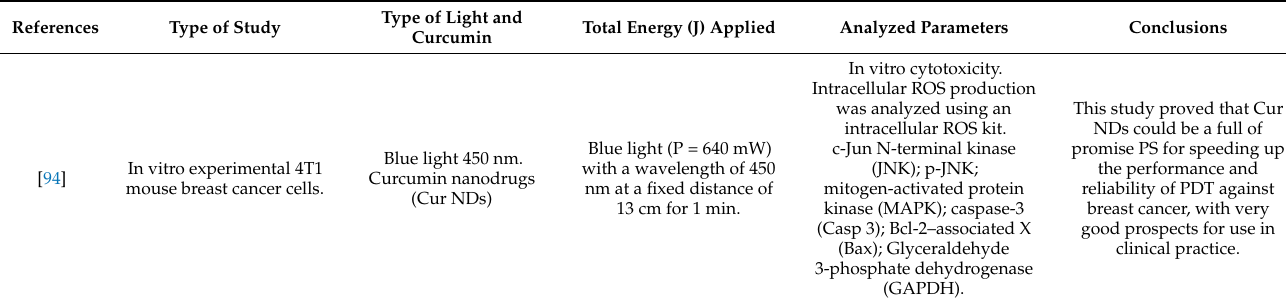
Table 1. Curcumin nanoformulations and PDT in breast